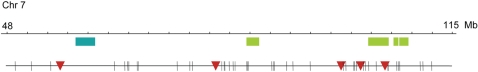
Region of mouse Chr 7 assayed and summary of results.
Upper line. The location in Mb of the PWS/AS locus is shown by the turquoise bar, and that of the OlfR clusters by the green bars. Lower line. The location of genes assayed for allele-specific expression is shown. Monoallelically expressed genes are indicated by red triangles; bi-allelically expressed genes by vertical lines (see text).